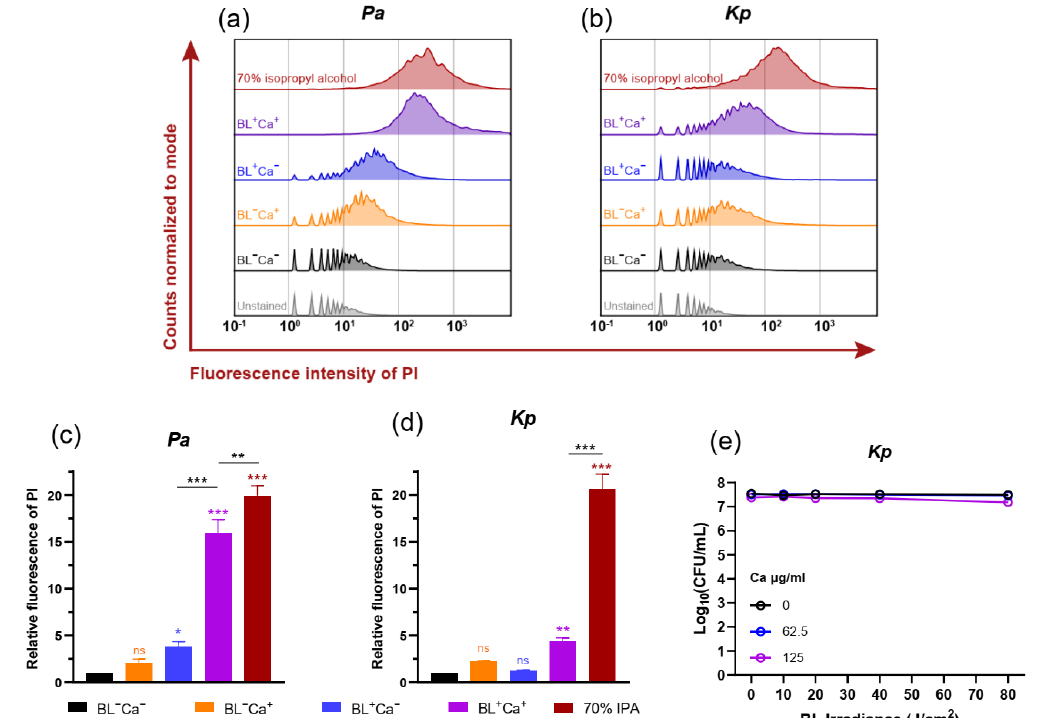
Figure 3. BL-Ca treatment permeabilizes bacterial membranes. ( a , b ) Representative histograms showing PI fluorescence intensities of P. aeruginosa (a) and K. pneumoniae (b) after different treatments. ( c , d ) Mean PI fluorescences of P. aeruginosa ( c ) and K. pneumoniae ( d ) after different treatments relative to the negative control (BL-Ca-). BL, 80 J/cm 2 and Ca, 125 µg/mL. ( e ) Survivals of K. pneumoniae IQ0035 after different treatments. Kp : K. pneumoniae ; Pa : P. aeruginosa . Results are presented as Mean ± SD of three independent experiments. *** p < 0.001; ** p < 0.01; * p < 0.05; and ns, no significance.